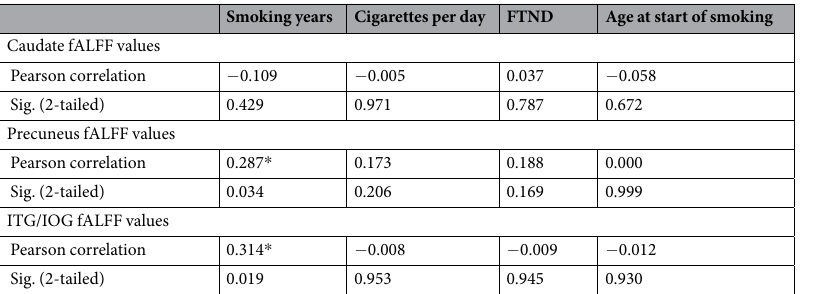
Table 3. Correlation analyses between the neuroimaging findings and cigarette smoking measures among 55 smokers. * Significant correlation at the level of 0.05 (2-tailed); FTND Fagerström test for Nicotine Dependence; ITG: inferior temporal gyrus; IOG: inferior occipital